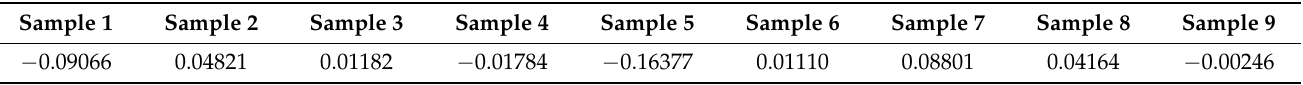
Table 5. Beta of each